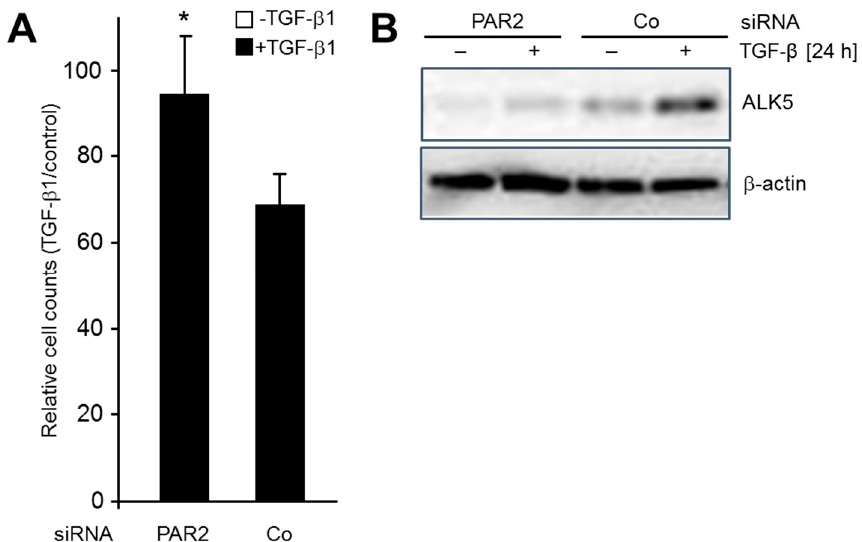
Figure 4. Effect of PAR2 knockdown on TGF- β 1-induced growth inhibition in Panc1 cells. ( A ) Panc1 cells were transfected twice with 50 nM of either PAR2 siRNA or Co siRNA. Forty-eight hours after the second round of transfection cells were treated, or not, with TGF- β 1 for 24 h, then detached and counted. Data are the mean ± SD of three experiments and are displayed as % reduction in cell numbers of TGF- β 1-treated cells relative to numbers of untreated control cells. The asterisk indicates a significant difference. ( B ) As in (A) except that cells were lysed after TGF- β 1 treatment and processed for immunoblotting of ALK5, and β -actin as a loading control.